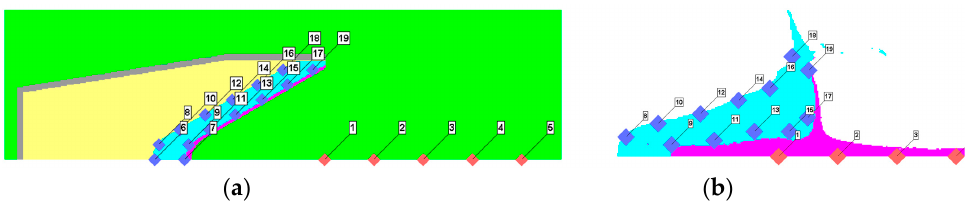
Figure 8. Gauge position settings: ( a ) gauges on the reactive material liner and axis of the SC; ( b ) gauges on the reactive material composite jet.